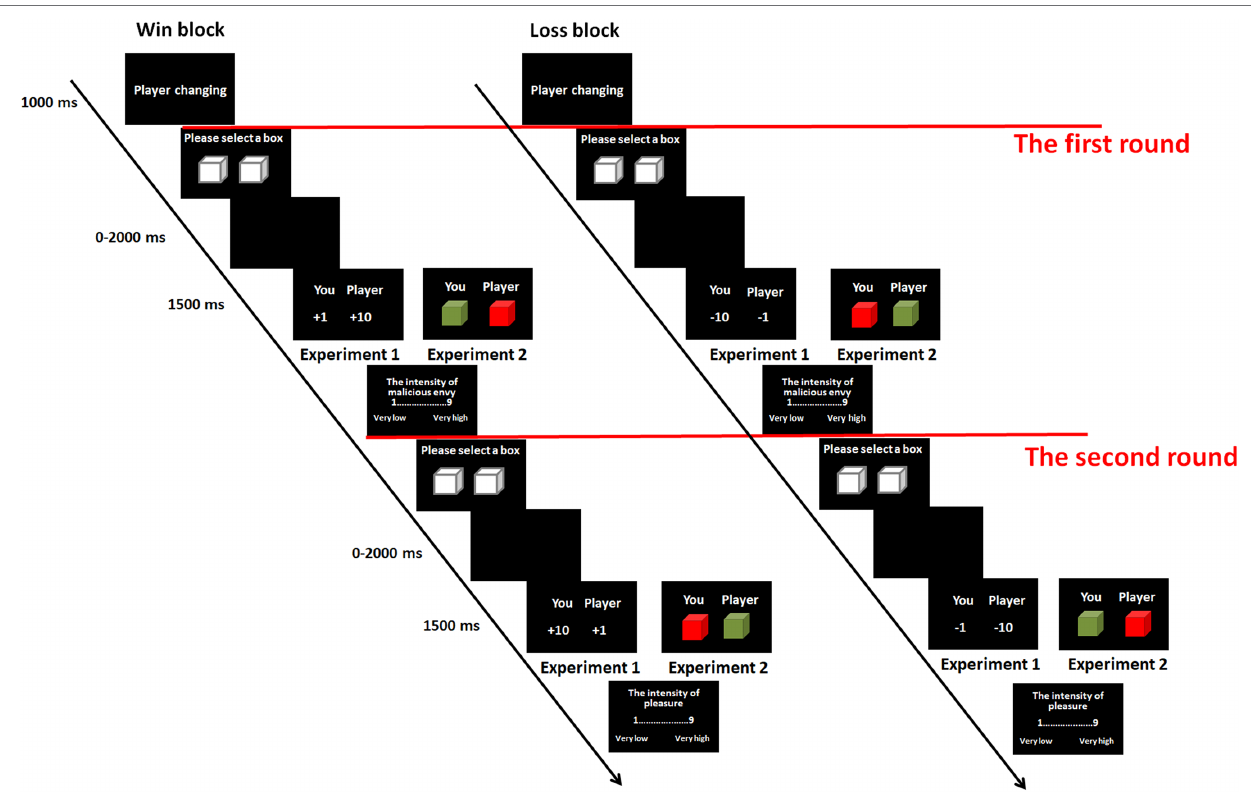
FIGURE 1 | Experimental procedure in Experiment 1 and 2. Each trial includes two rounds. The first round was to elicit malicious envy, and the second round was to assess